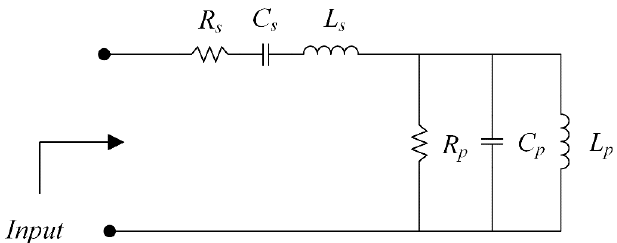
Figure 5. The equivalent circuit model of an inverted L-shaped planar monopole antenna on a partial ground plane in vacuum and with FR-4 substrate.